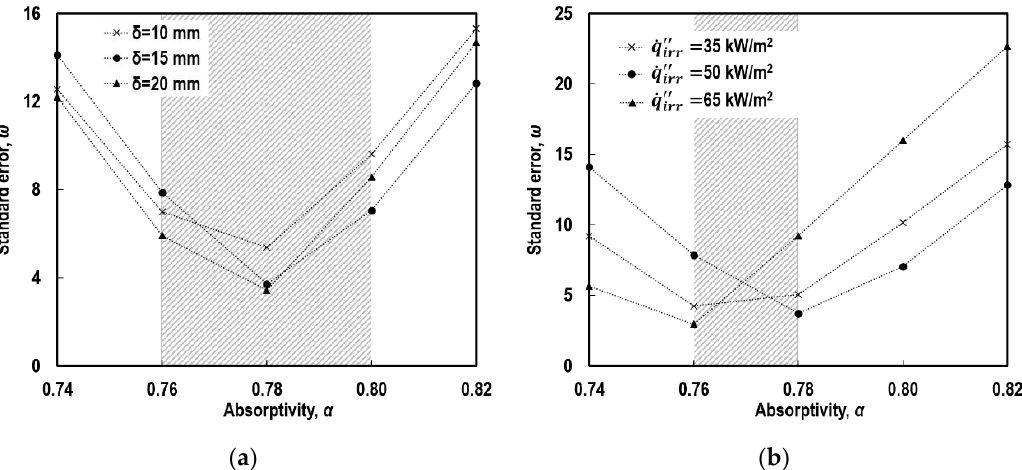
. = 50 kW / m 2 q (cid:48)(cid:48) irr